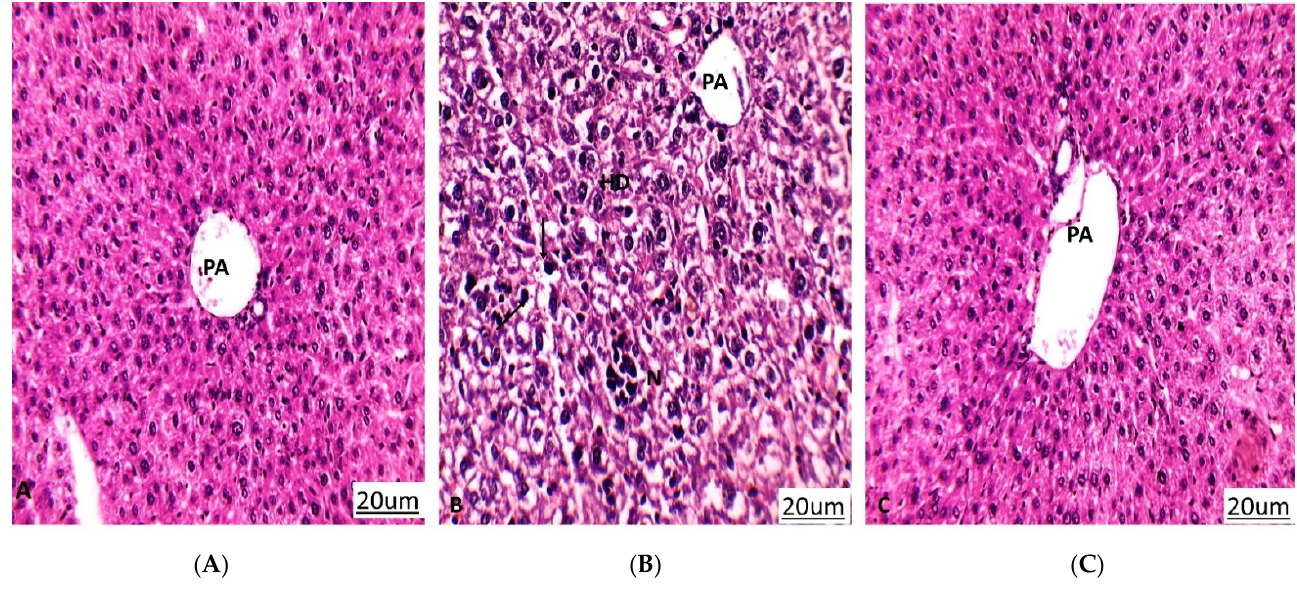
Figure 5. Histopathology of liver sections in differently treated groups. PA: portal area, HD: hydropic degeneration, N: necrosis, Black arrow: Pyknotic nucleus. ( A ) Normal control group that shows liver tissues with a normal architecture. ( B ) A549 group (untreated group) that shows hydropic degeneration of hepatocytes, loss of cell boundaries, pyknosis, and focal necrosis. ( C ) A549 group treated with A. judaica (100 mg/Kg BW) that shows improvement in liver tissues compared to the untreated A549 group. (Hematoxylin-eosin stain, magnification ×200).